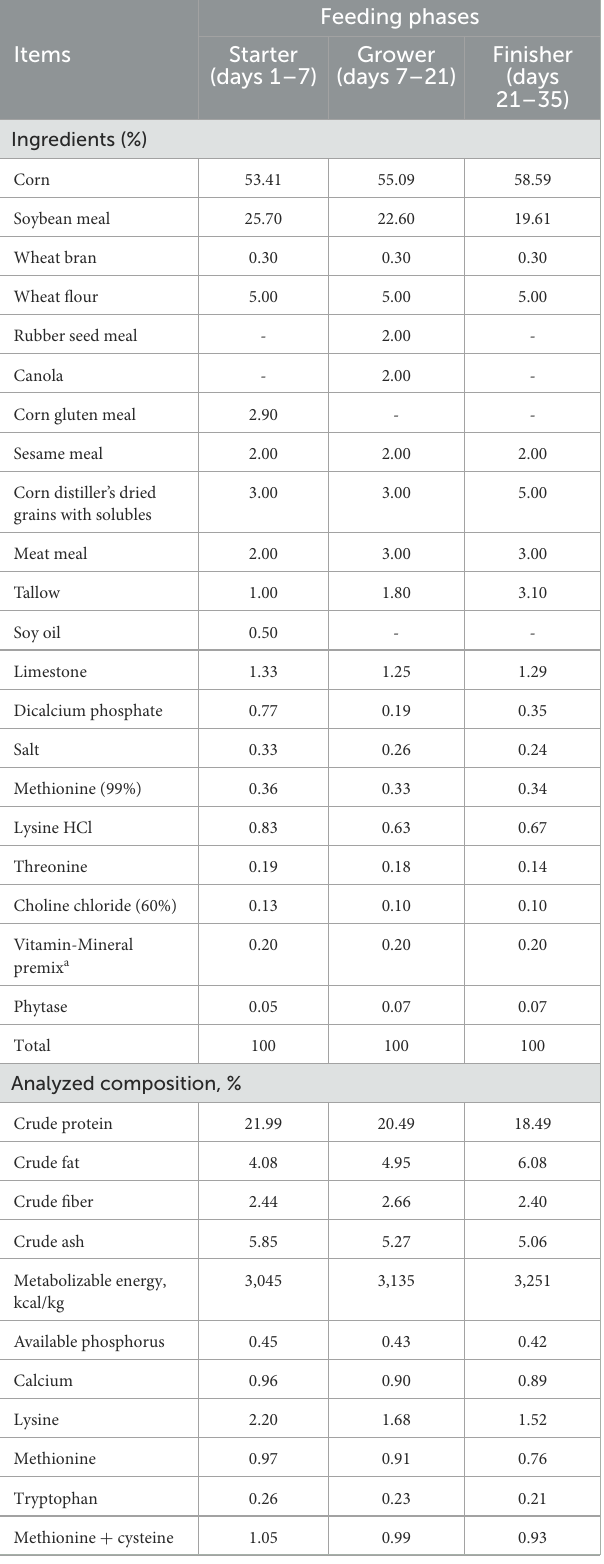
TABLE 1 Composition and nutrient levels of the experimental basal diet, (%, as-fed basis).